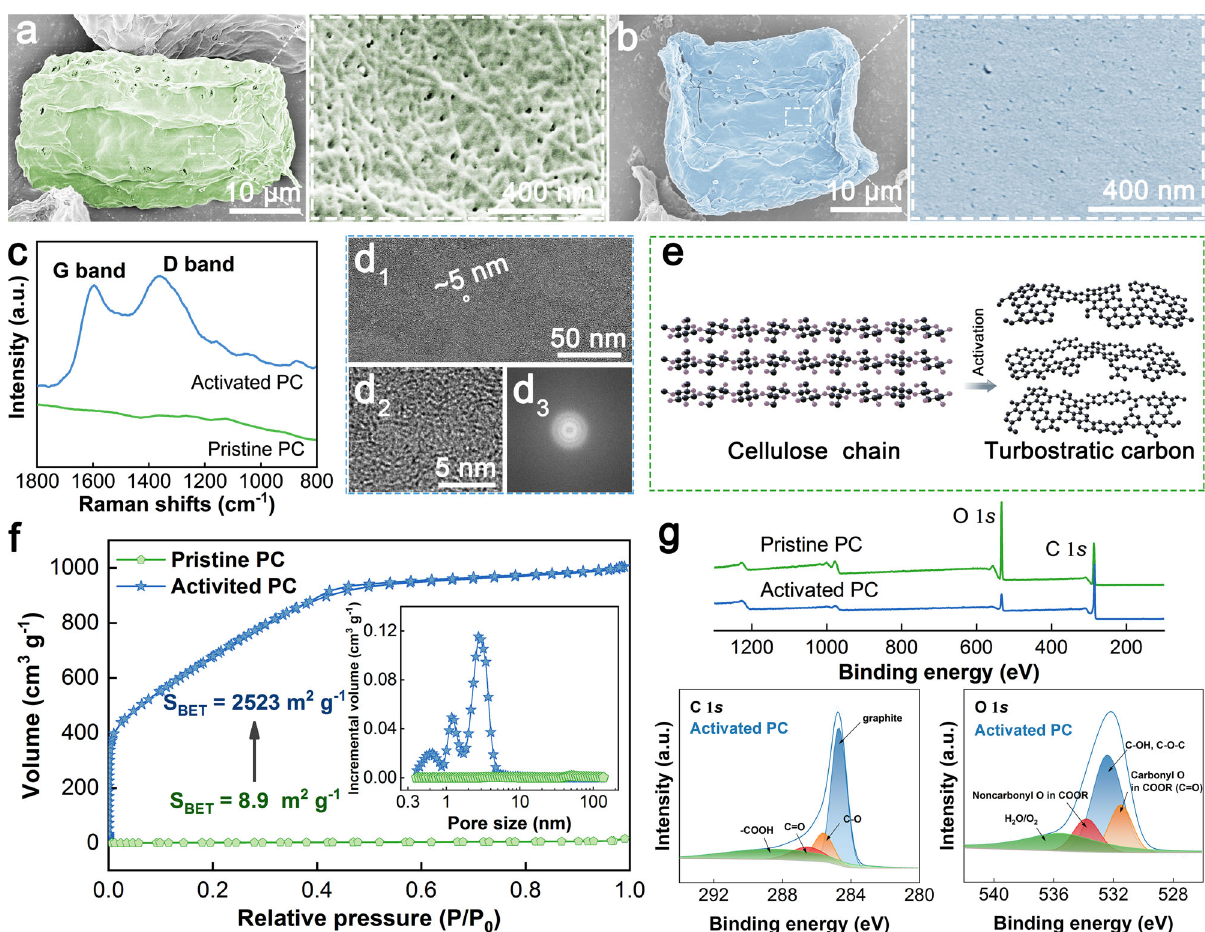
Fig. 3 Structure and porosity of activated PCs. Arti fi cial-color SEM images of a pristine and b KOH-activated PC. c Raman spectra of the pristine and activated PC. d TEM (d 1 ), HRTEM image (d 2 ) and SAED pattern (d 3 ) of activated PC indicating the pore structure and amorphous structure. e Structural evolution of the PC from a parallel cellulose chain structure to the disordered graphite structure. f N 2 adsorption/ desorption isotherms of pristine and activated PCs; inset: pore-size distribution curves of pristine and activated PCs. g XPS spectrum of pristine PCs and activated PCs and curve fi tted high resolution XPS scans for C 1 s and O 1 s